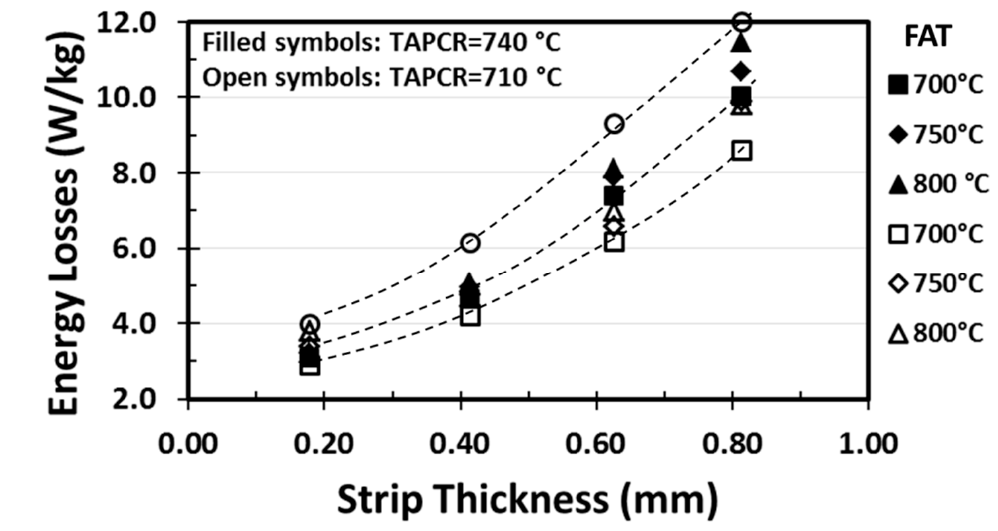
Figure 11. Effect of temperature of annealing prior to hot rolling (TAPHR), final annealing temperature (FAT) and strip thickness on energy losses. Data for material not annealed prior to cold rolling are indicated by open circles.